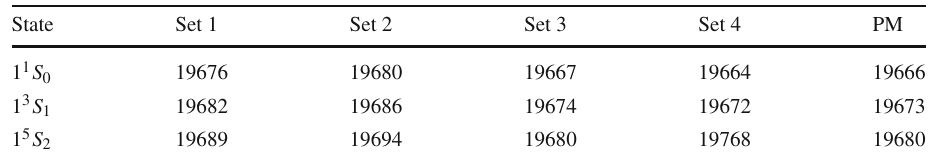
Table 14 Responses in cc ¯ c ¯ c tetraquark mass values to potential parameter input in group 2. PM stands for results of potential model used in this work. All results are in MeV